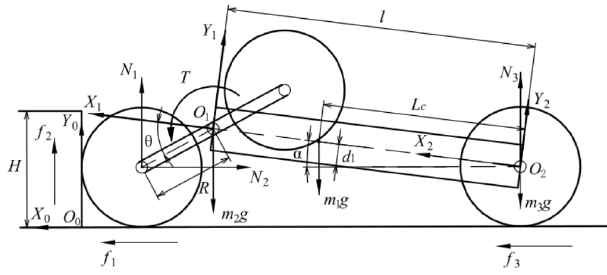
Figure 13. The static condition of the robot in the obstacle-crossing phase (b).